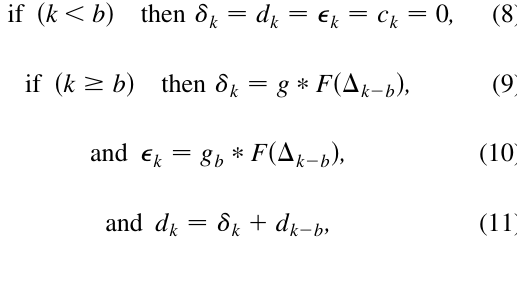
FIG. 9. Modified fast intrapulse feedback system to avoid the oscillations created by the beam blowup. Compared to the FEATHER [4] circuit one extra branch has been added that directly takes the beam position signal and bypasses the delay loop.